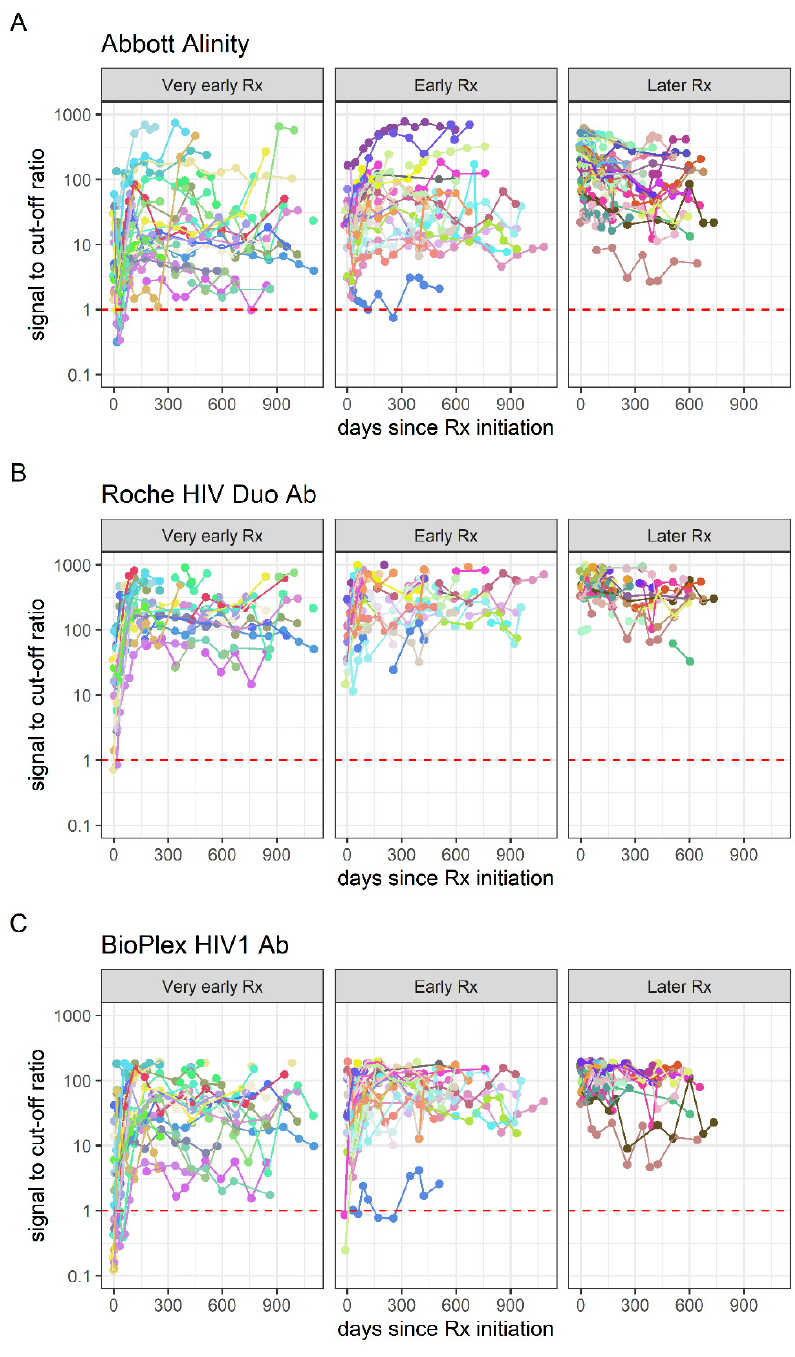
Figure 1. Quantitative signal intensity over time since treatment (Rx) initiation, stratified by time from infection to treatment initiation, in three high-throughput HIV blood screening assays. Panel ( A ): Abbott HIV Combo on the Alinity s platform, Panel ( B ): Roche Elecsys HIV Duo on the cobas e801 platform, and Panel ( C ): Bio-Rad BioPlex 2200 HIV assay. The dotted red lines indicate the cut- offs for positivity.